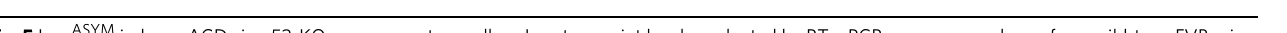
Insc ASYM mutant associating with LGN TPR in a 1:1 stoichiometry.